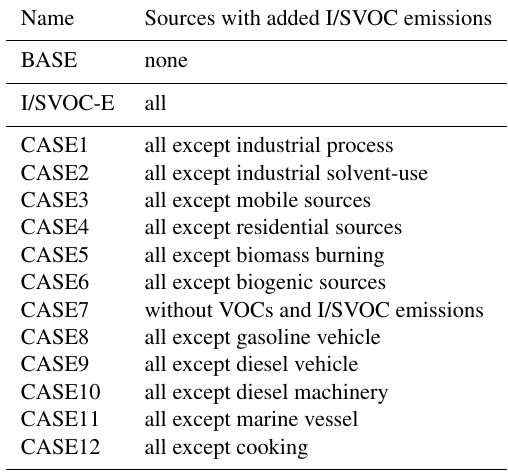
Table 1. Settings of the simulation